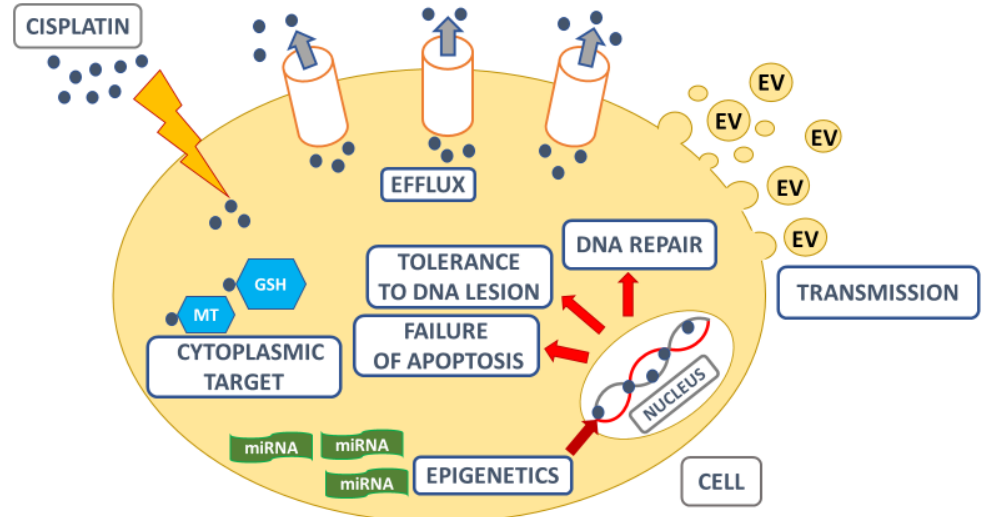
Figure 1. Molecular mechanisms of cisplatin resistance. GSH, reduced glutathione; MT, metallothioneins; EV, extracellular vesicles.